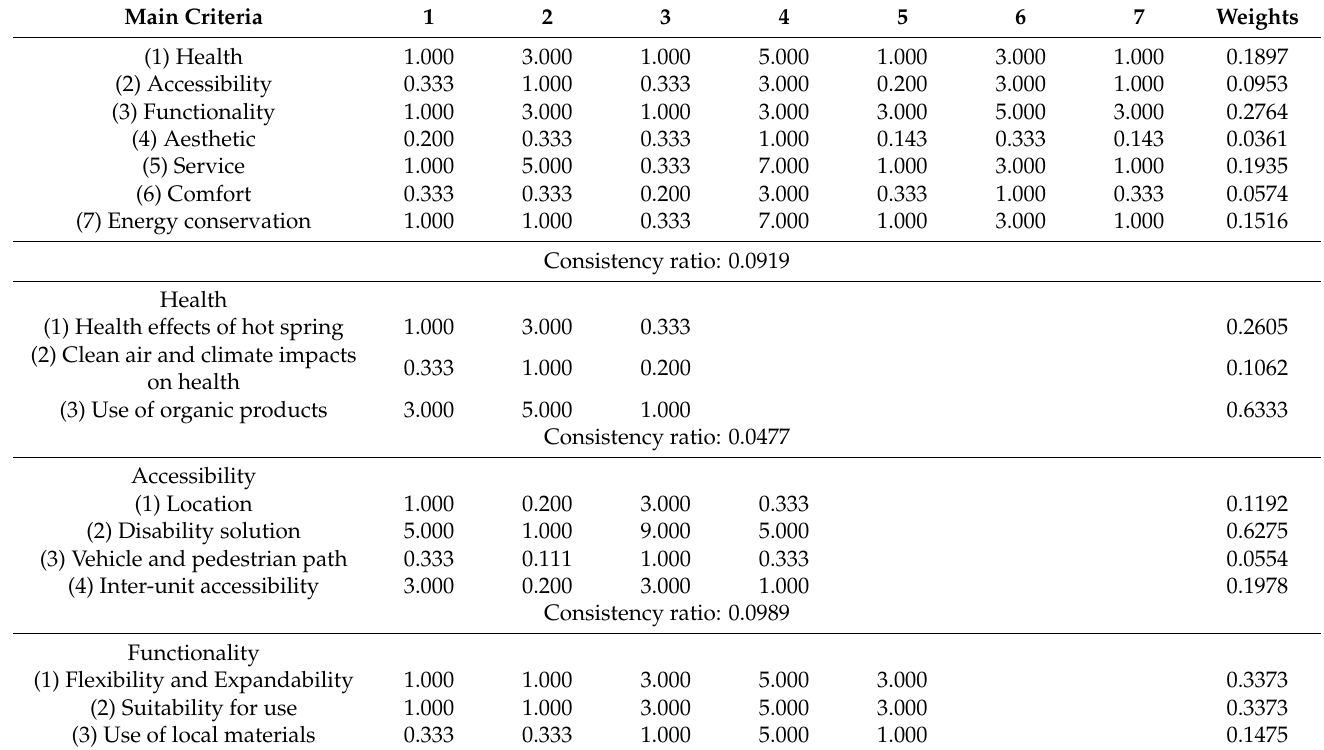
Table 3. AHP pairwise comparison matrices result table (Questionnaire